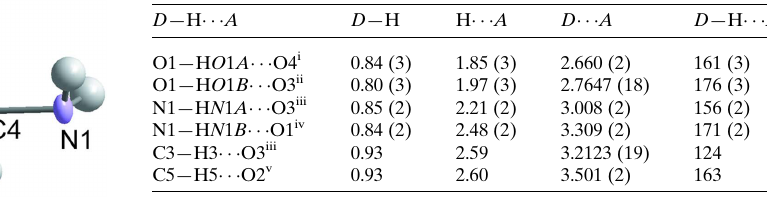
Table 1 Hydrogen-bond geometry (A˚ , (cid:5)